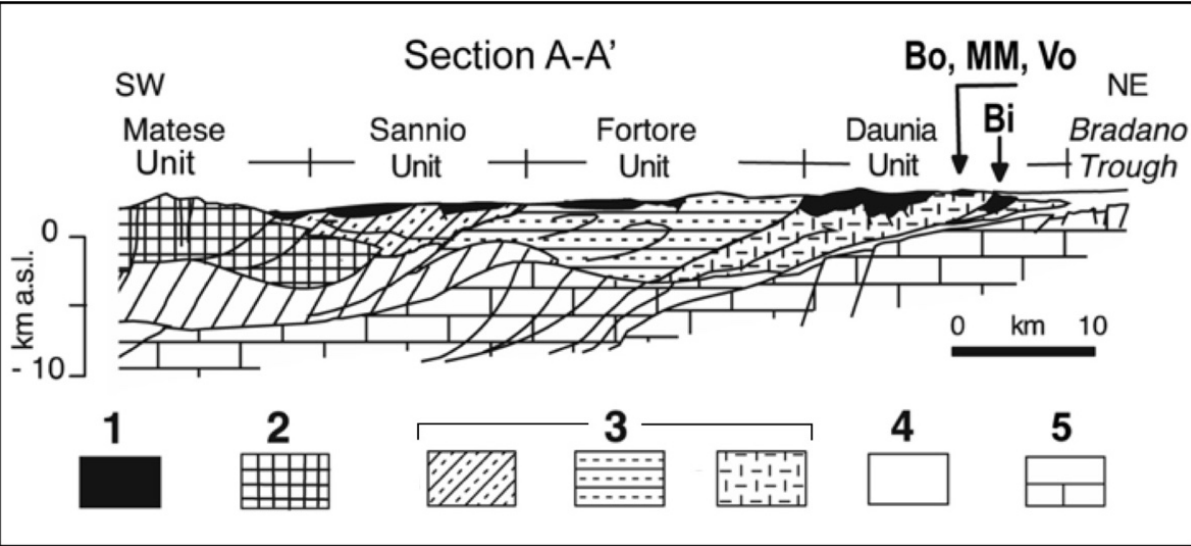
Figure 2. Schematic geological cross-section A–A’ through the northeastern edge of the Sannio– Daunia Apennines within which the studied slopes are located (after [35], modified). Trace of the cross-section shown in Figure 1. Key: (1) Plio–Miocenic Silicoclastic Units; (2) Apennine Platform Units; (3) Upper sequences of the Lagonegro–Molise Units: Sannio Unit (left), Fortore Unit. (mid- dle), Daunia Unit (right)—Faeto Flysch outcropping at Bovino (Bo), Motta Montecorvino (MM), Volturino (Vo) and Biccari (Bi) slopes); (4) Bradano Through Unit; (5) Apulian Platform Units.